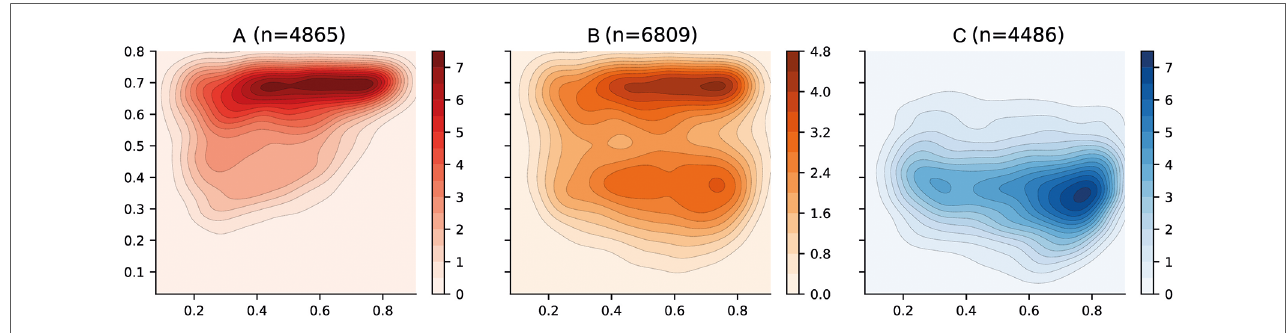
FIGURE 6 Latent space description: Categories. The graphs represent the density distribution over the latent space for three categories (A, B and C) estimated using a Gaussian kernel. These categories are de fi ned as a compendium of various phenotypes (see Table 2 ) and therefore the value on each bin (pixel) described in the colorbar represents the estimated density on that bin for which one or more of the conditions associated to the category